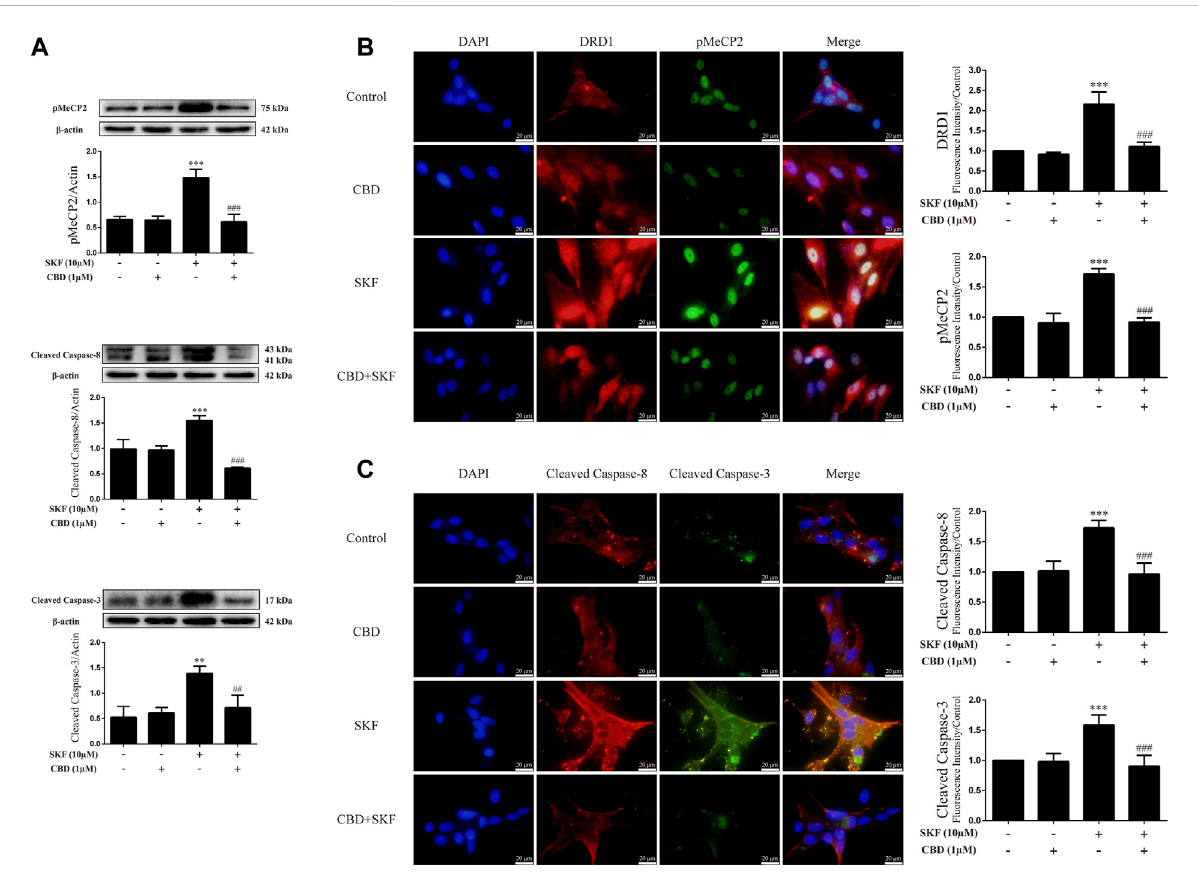
FIGURE 7 Protein levels and colocalization in neurons incubated with CBD and/or SKF81297. (A) Levels of pMeCP2 and apoptosis-related proteins. (B) DRD1 and pMeCP2 levels and their colocalization. (C) Cleaved caspase-8 and cleaved caspase-3 levels and their colocalization. ** p < 0.01 or *** p < 0.001 compared with control group, ## p < 0.01 or ### p < 0.001 compared with METH group; Tukey HSD post-hoc comparison after signi fi cant